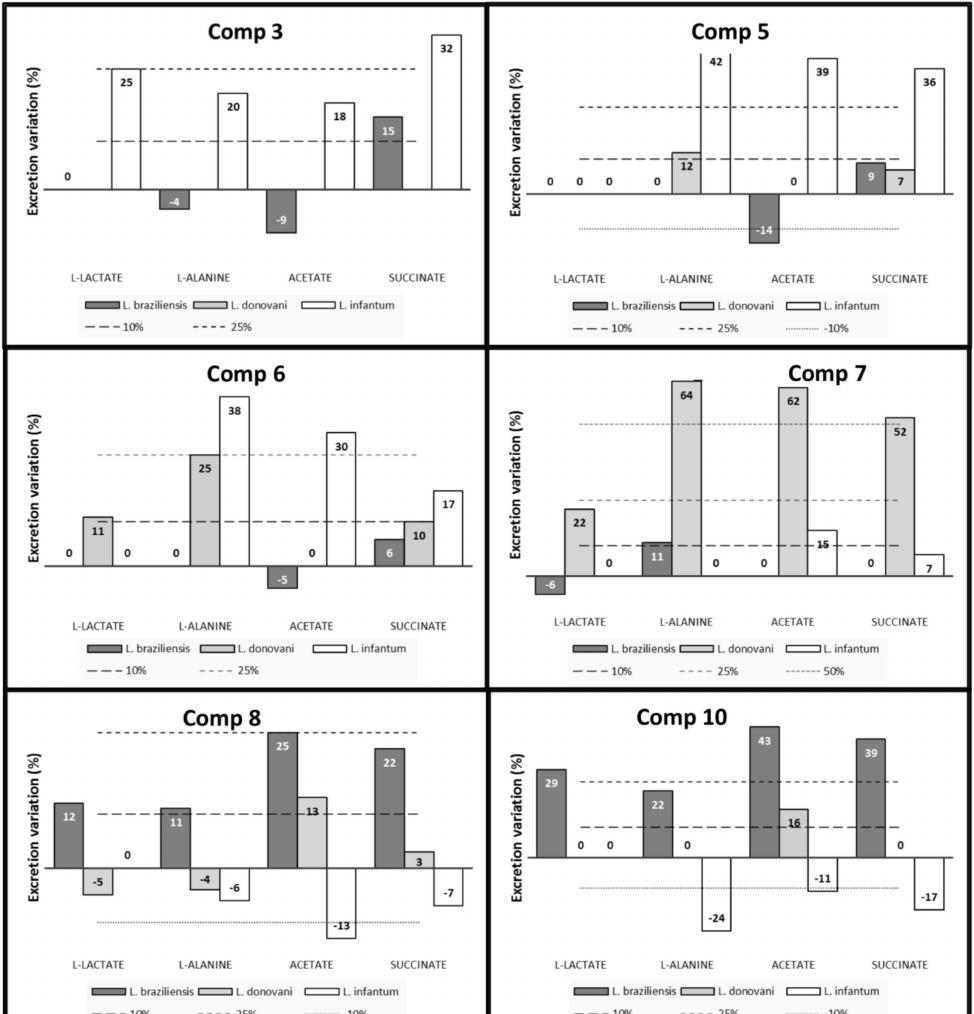
Figure 6. Variation in metabolic excretion in L. braziliensis , L. donovani and L. infantum exposed to compounds at IC 25 concentrations in comparison to untreated incubated 72 h, and determined by 1